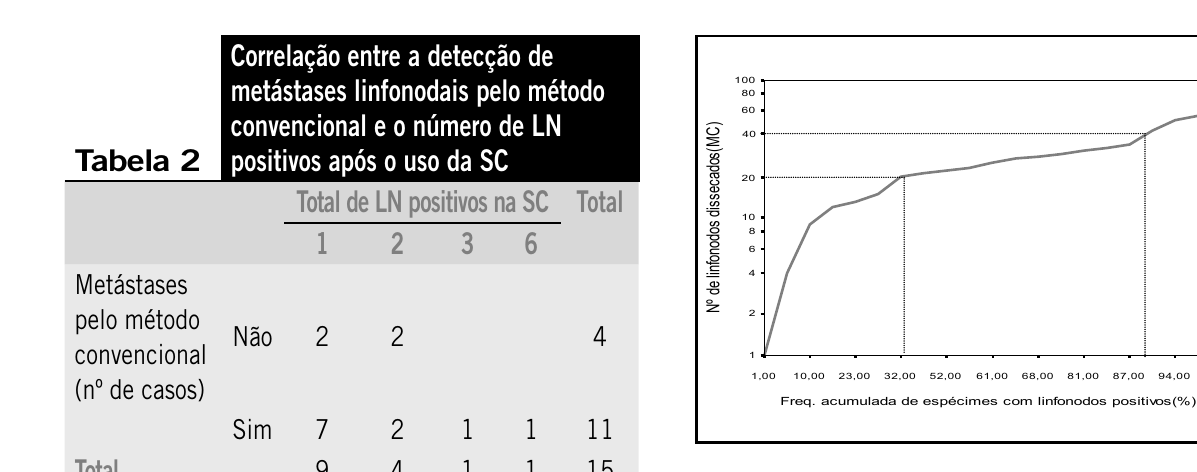
Figura 4 – Relação entre o número de linfonodos dissecados pelo método convencional (MC) e a freqüência acumulada de casos com